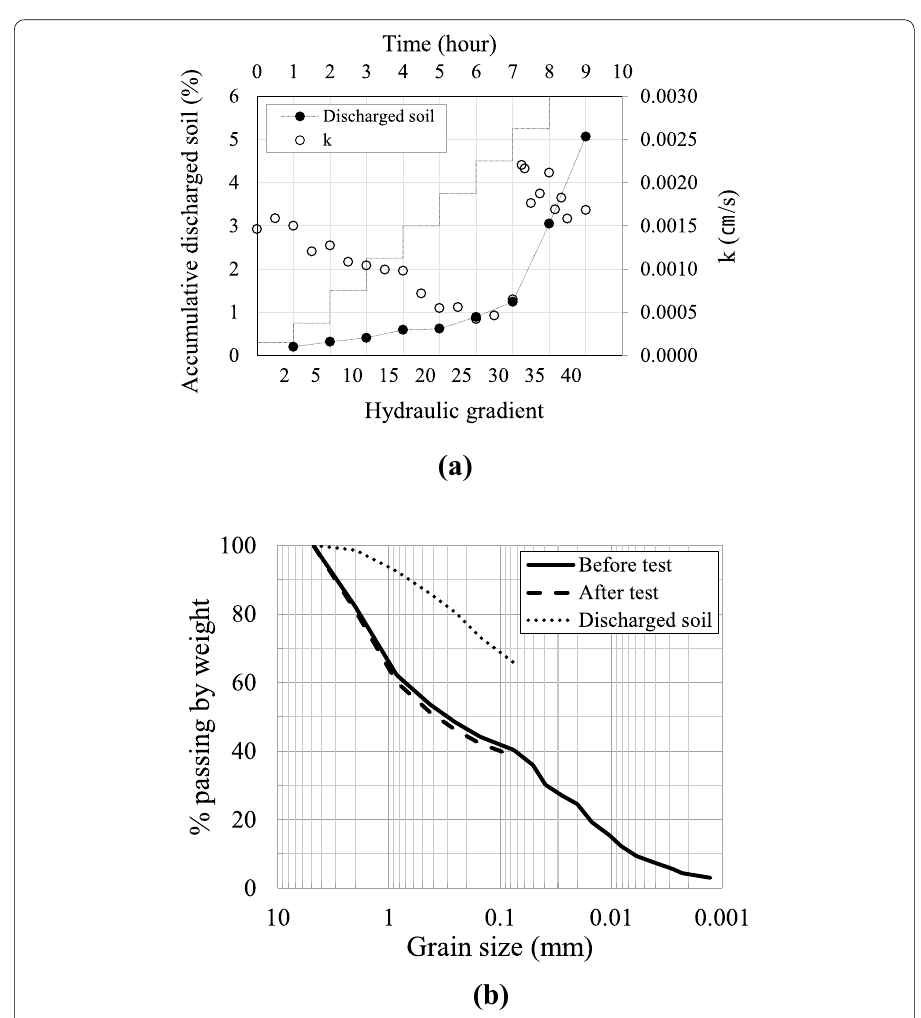
Fig. 4 Short‑term test result of Gwanak soil: a accumulative discharged soil and k ; and b grain size distribution after the